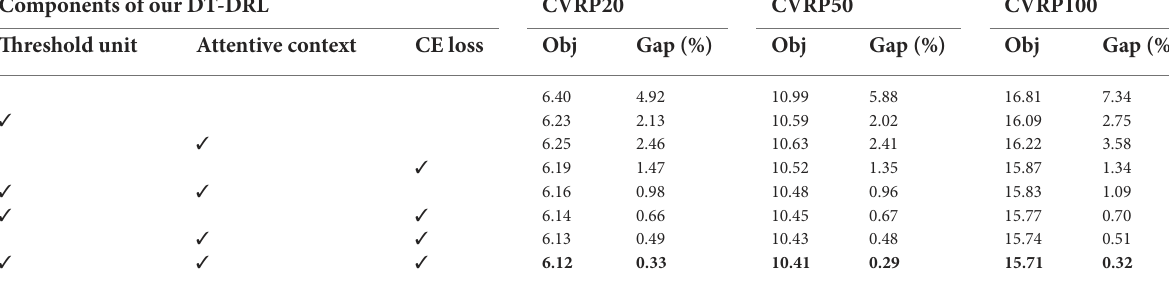
TABLE 4 AblationstudyofdifferentcomponentsofourDT-DRLonCVRP. Components of our